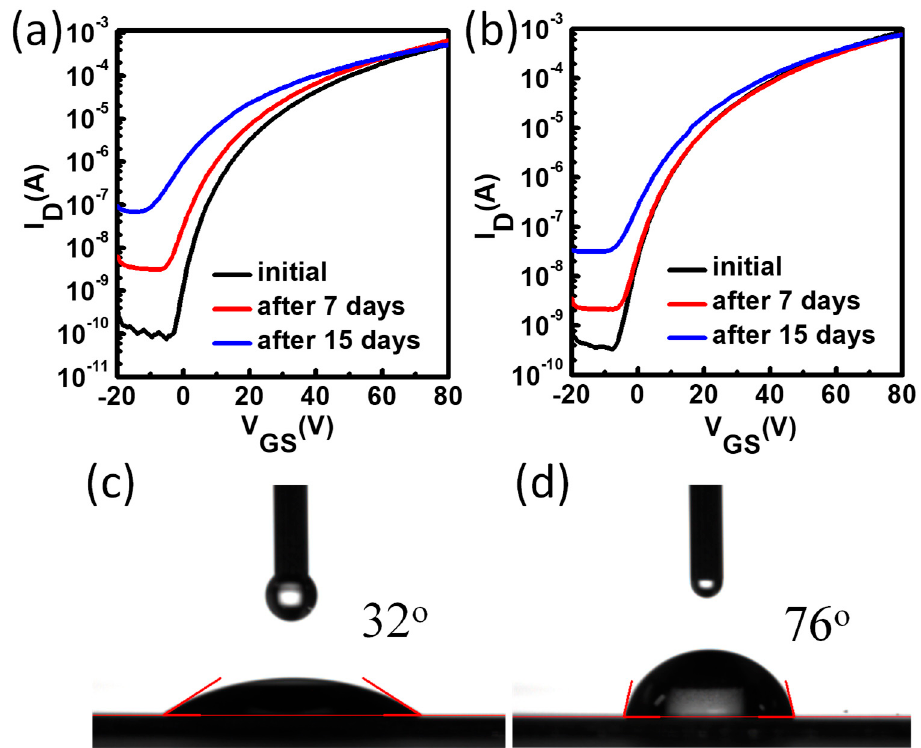
Figure 4. The transfer characteristics of the pristine ZnO TFTs ( a ) and the ZnO TFTs with PCBA interfacial modification layers ( b ). The water contact angle of pristine ZnO ( c ) and ZnO film with PCBA treatment ( d ).